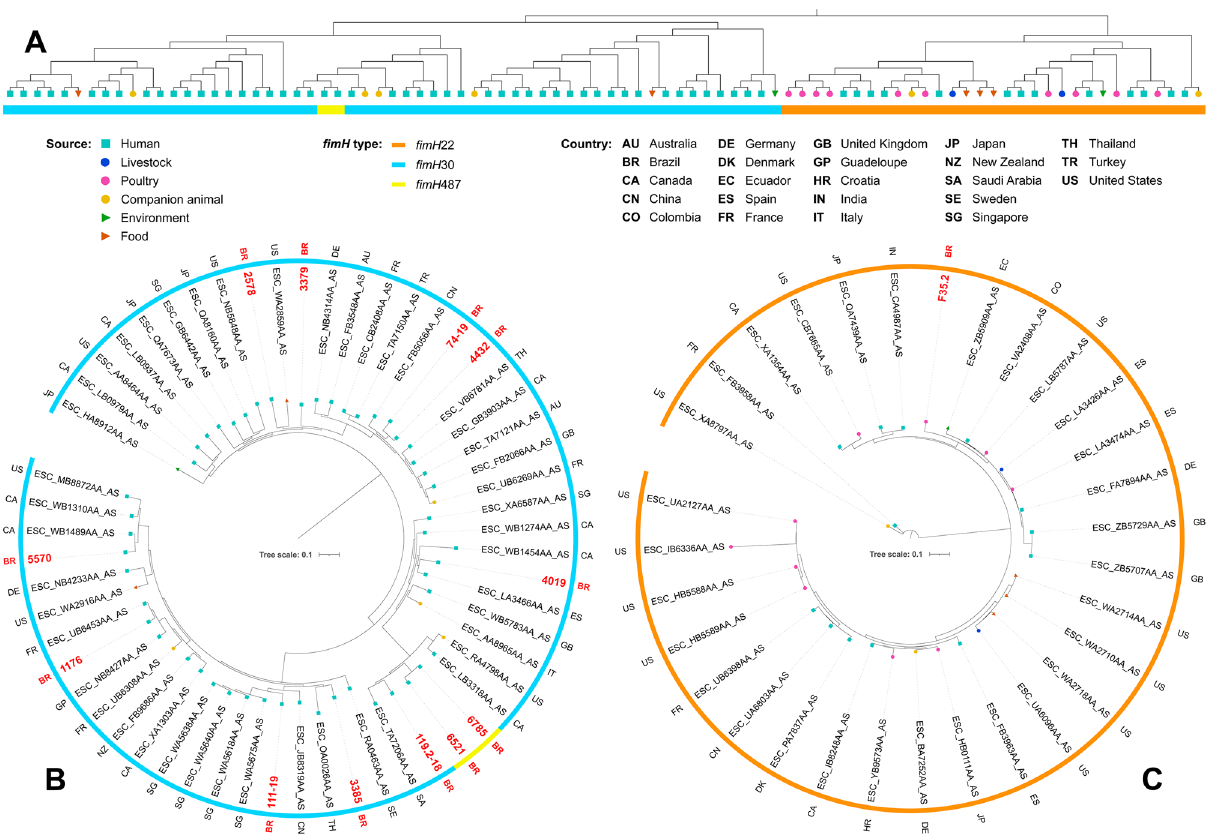
Figure 4. ( A ) Unscaled phylogenetic tree with the source and fimH type of 88 Escherichia coli ST131strains. ( B ) Subtree containing fimH 30 and fimH 487 isolates showed in ( A ), their source, fimH type and country of collection. ( C ) Subtree containing fimH 22 isolates showed in ( A ), their source, fimH type and country of